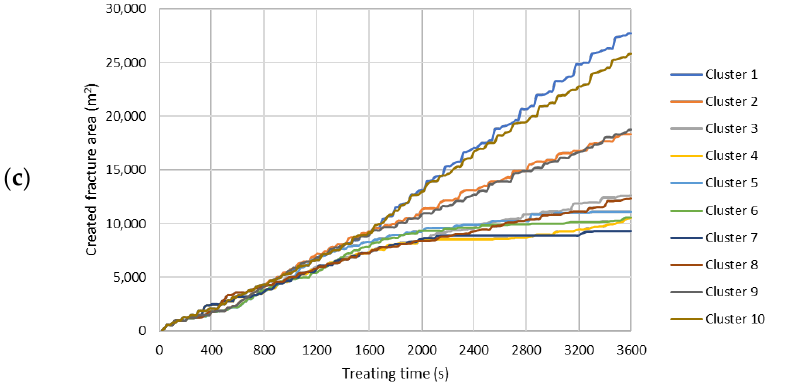
Figure A4. Created fracture surface area of each cluster during the hydraulic fracturing treatment.